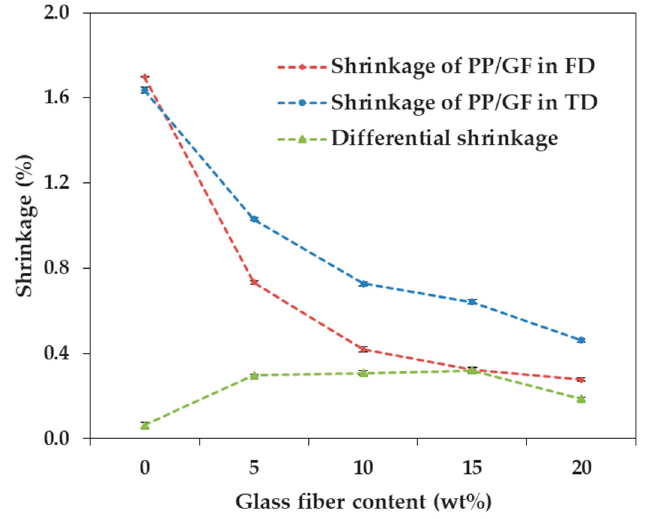
Figure 7. Shrinkage of PP/GF as a function of glass fiber content.